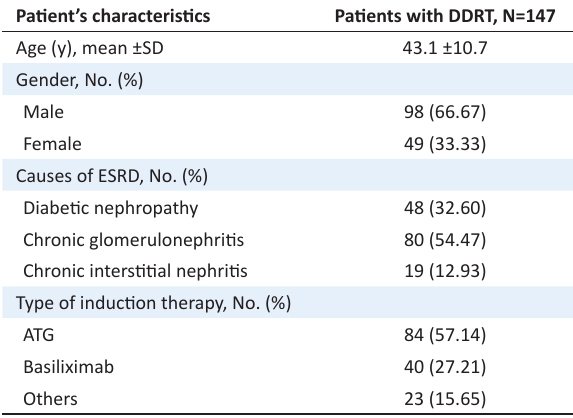
Table 1. Baseline characteristics of the study patients Patient’s